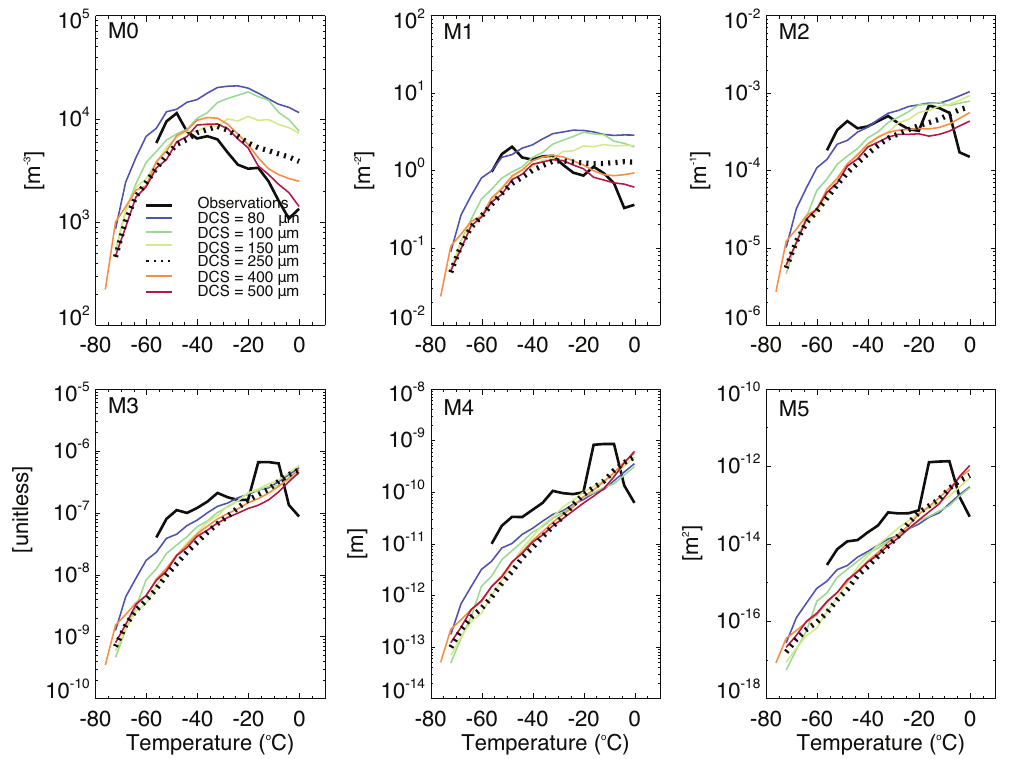
Fig. 10. Same as Fig. 4, (ARM-­‐IOP) but with various D cs values 1057 Figure 10. Same as Fig. 4, (ARM-IOP) but with various D cs